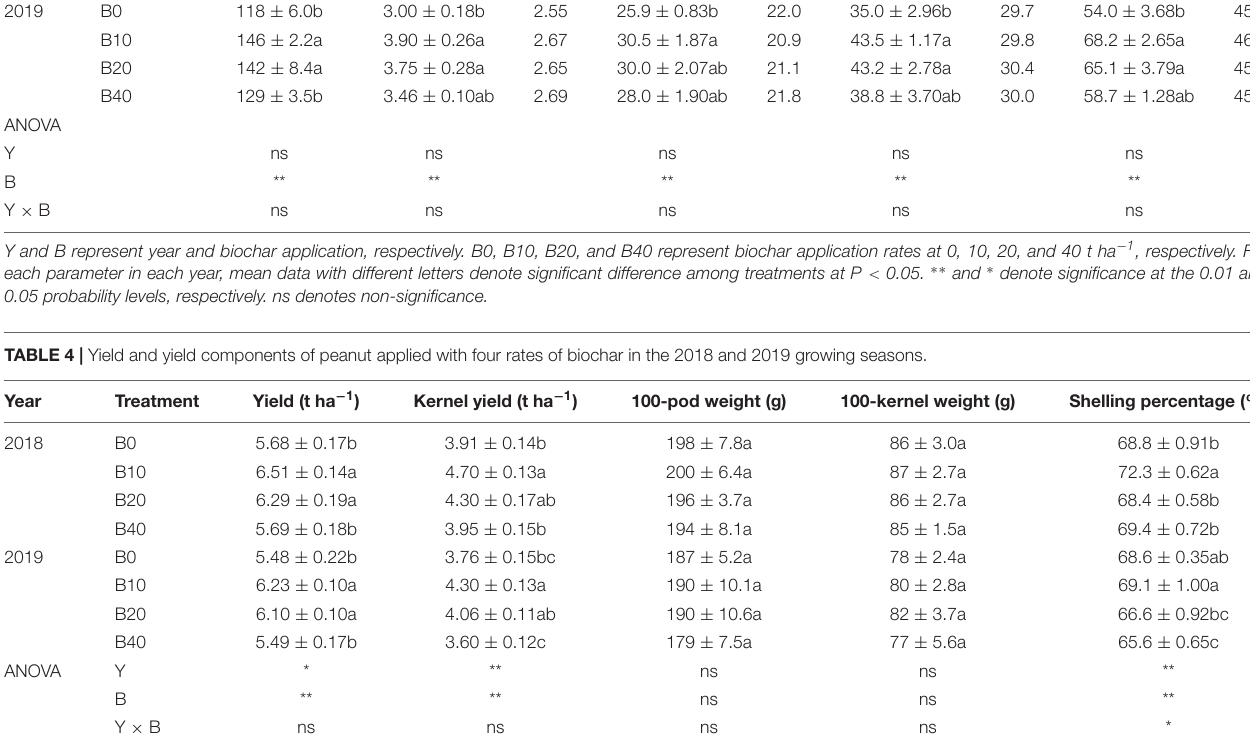
Y and B represent year and biochar application, respectively. B0, B10, B20, and B40 represent biochar application rates of 0, 10, 20, and 40 t ha − 1 , respectively. For each parameter in each year, mean data with different letters denote significant differences among treatments at P < 0.05. ∗∗ and ∗ denote significance at the 0.01 and 0.05 probability levels, respectively. ns denotes